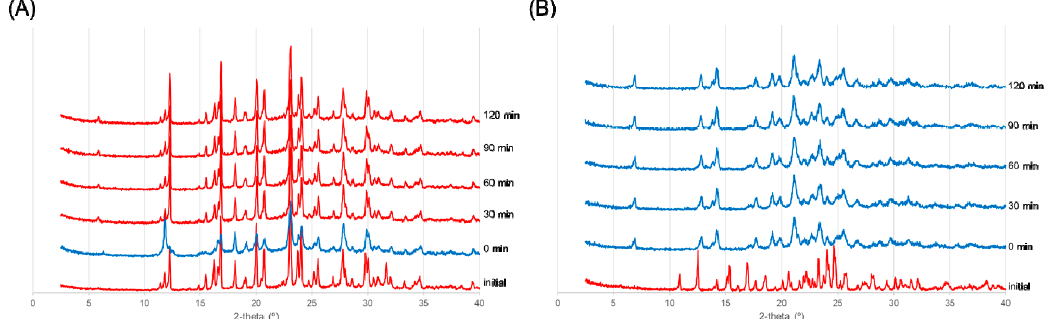
Figure 4. Reversibility after heating was confirmed from X-ray diffraction patterns. Red indicates the dihydrate diffraction pattern, and blue indicates the anhydrate diffraction pattern. ( A ) HBr salt and ( B ) HI salt.